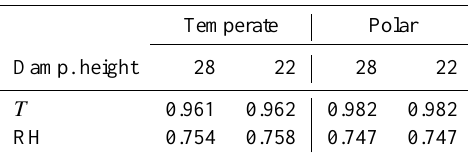
Table C2. Correlation coefficients for the two model runs forced by ERA-Interim against measurements, using 28 or 22km as lowest extents of the damping layer for polar and temperate stations and both variables, T and